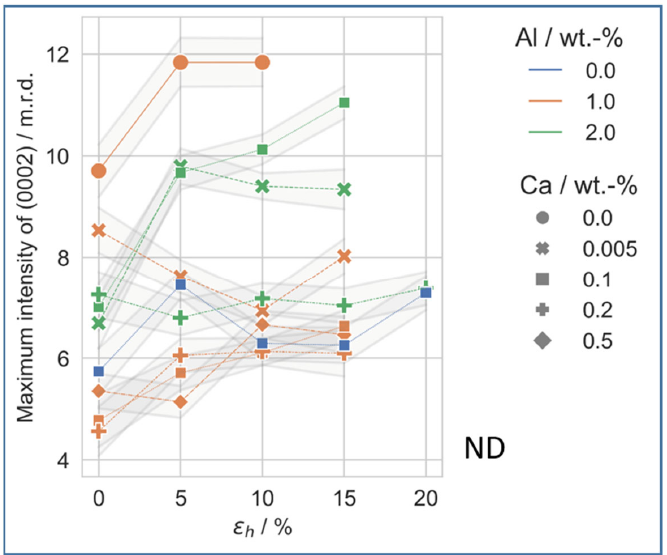
Figure 4. Maximum intensities of the basal (0002) peak for S_ND samples related to the relative height reduction ( ε h ) during cold rolling, including the absolute mean error resulting from the recalculation.